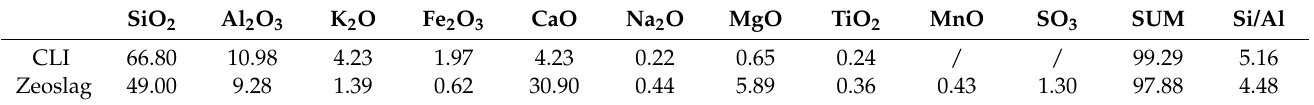
Table 1. Chemical composition of the starting materials. The results were obtained by XRF